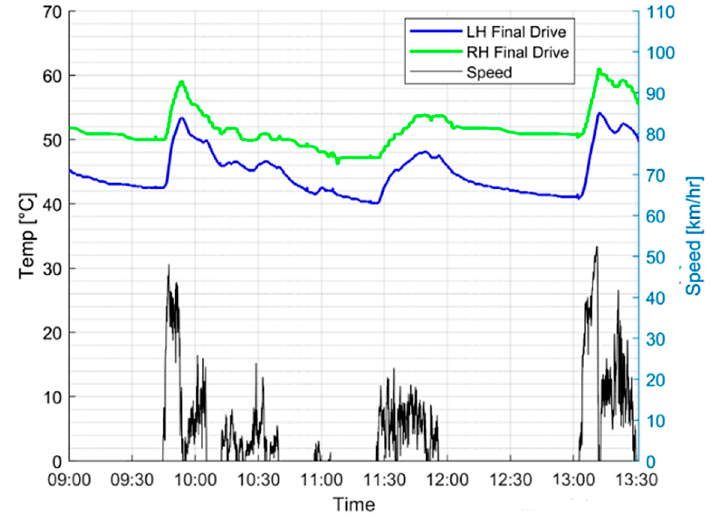
Figure 10. Variation of final drive temperature (vehicle speed shown as reference).